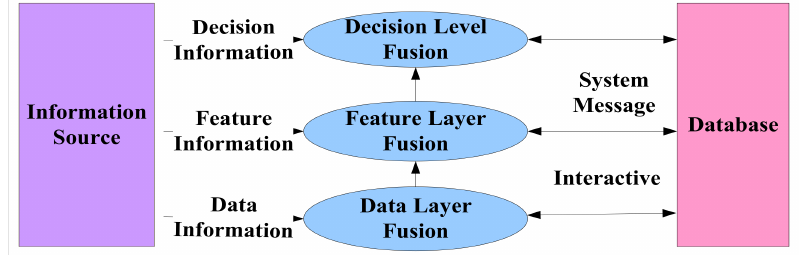
Figure 5. Information fusion